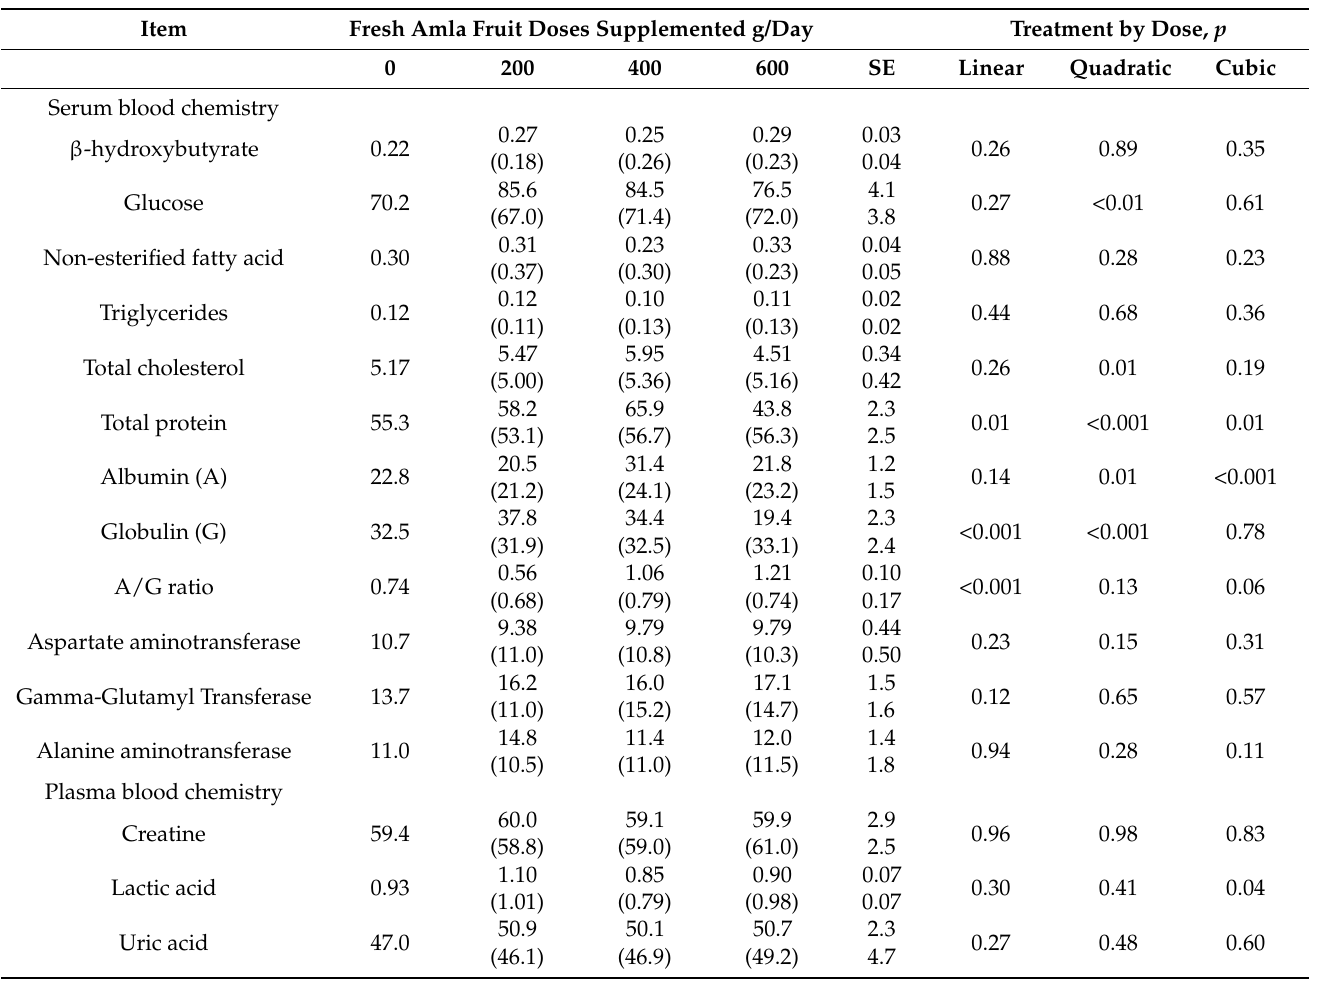
Table 6. Serum and plasma biochemistry of lactating cows fed a TMR without